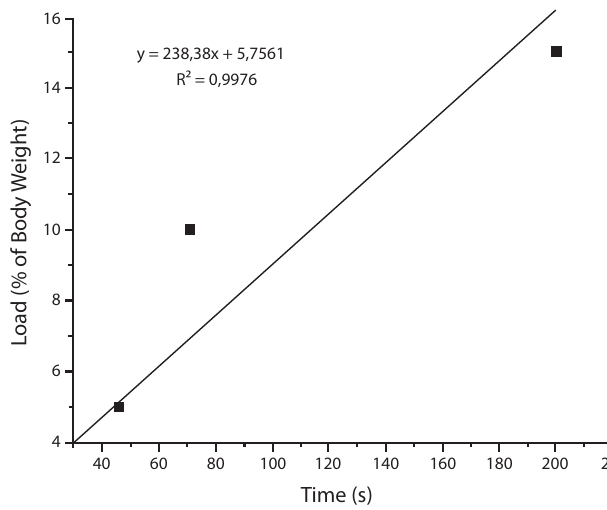
Figure 1: CL scatter plot with real values of the test performed by one animal. In this case, the Lan corresponded to ≈5.76% of the